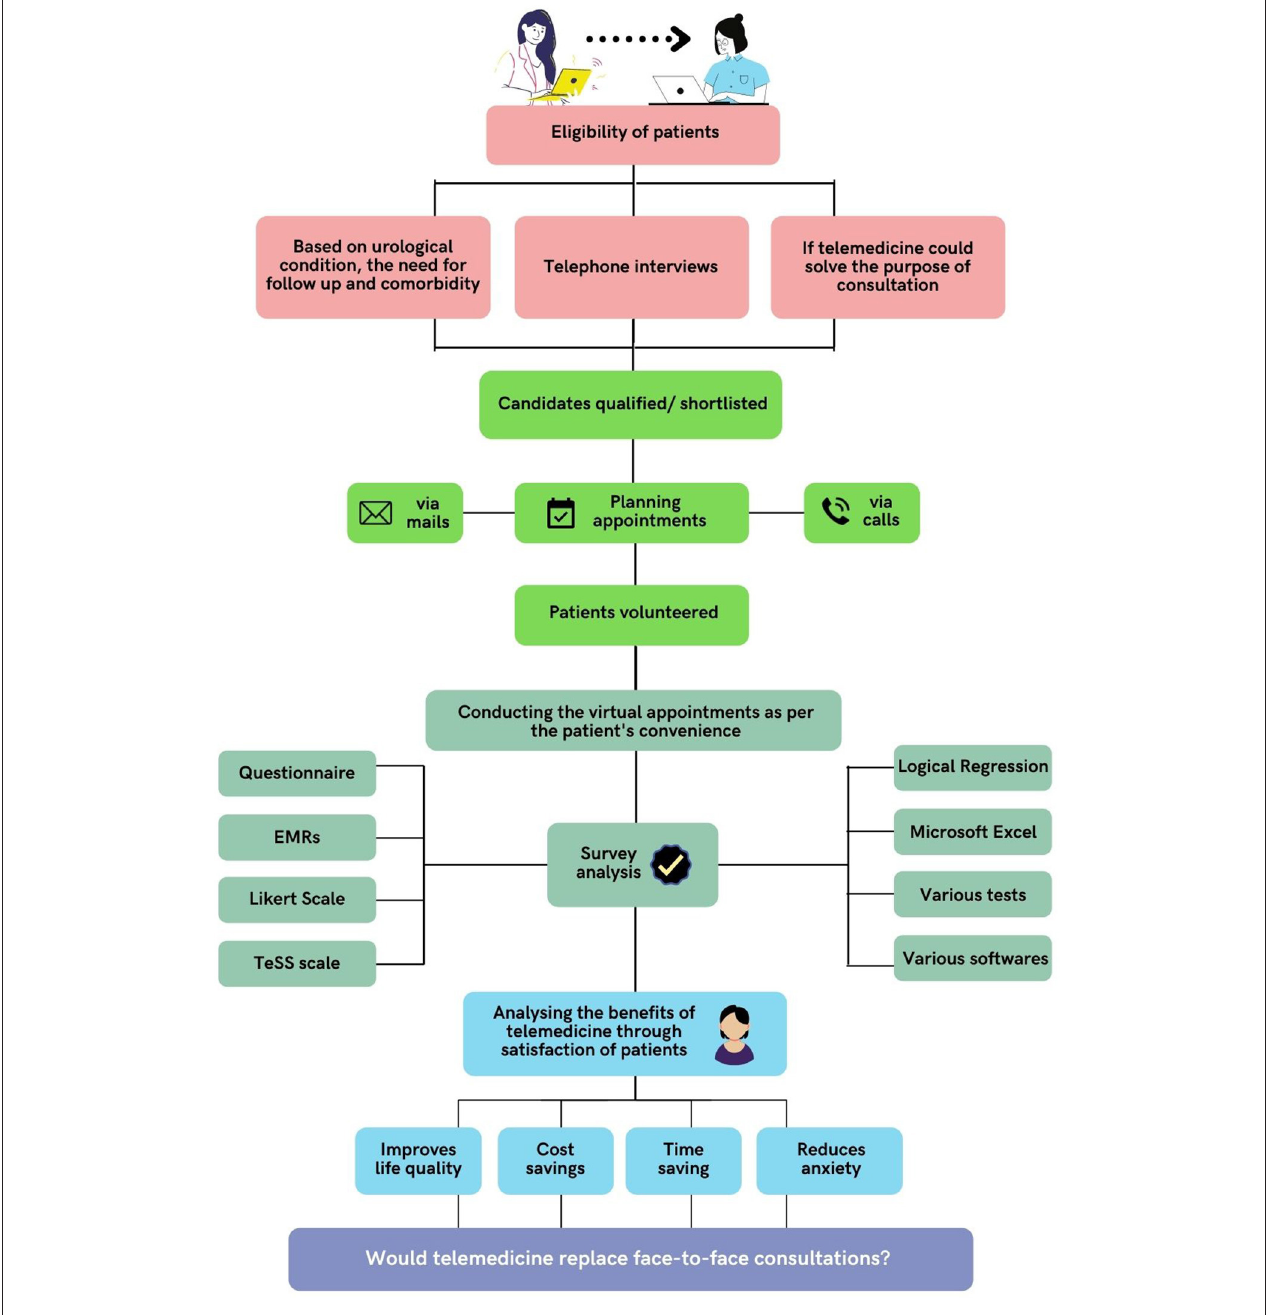
FIGURE 1 | Process flow of telehealth/telemedicine tools for patient consultation.